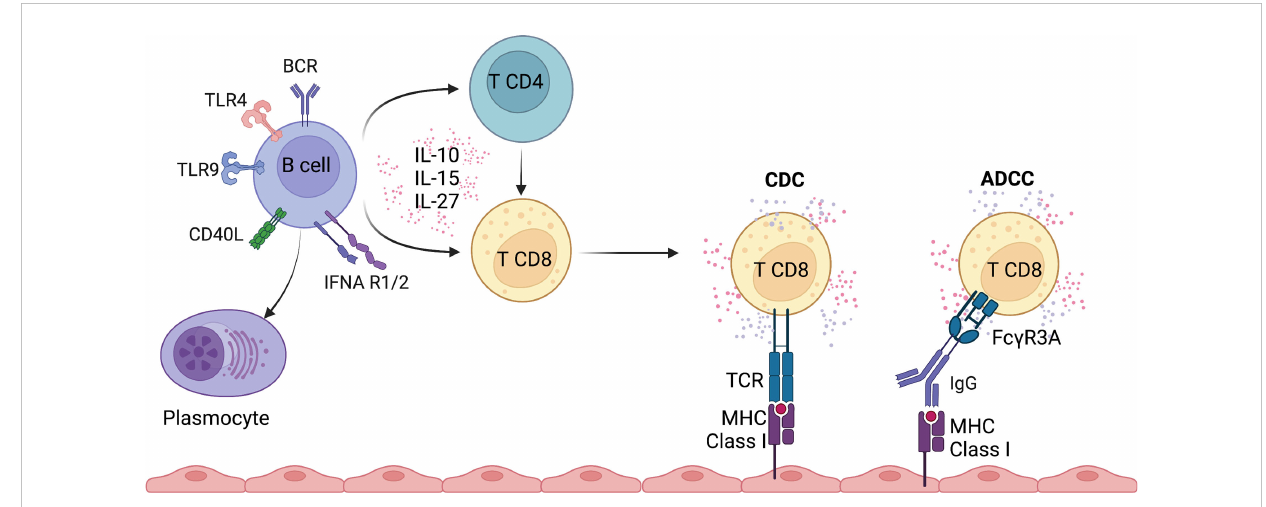
FIGURE 2 Overview of potential pathways involved in the regulation of CD8 T cell function by B